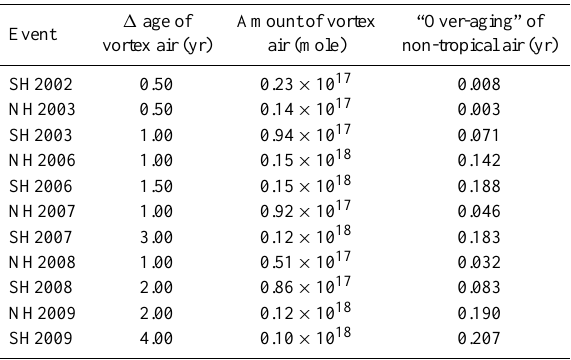
Table 1. “Over-aging” of non-tropical air due to in-mixing of meso- spheric, SF 6 -depleted air. 1 age Event